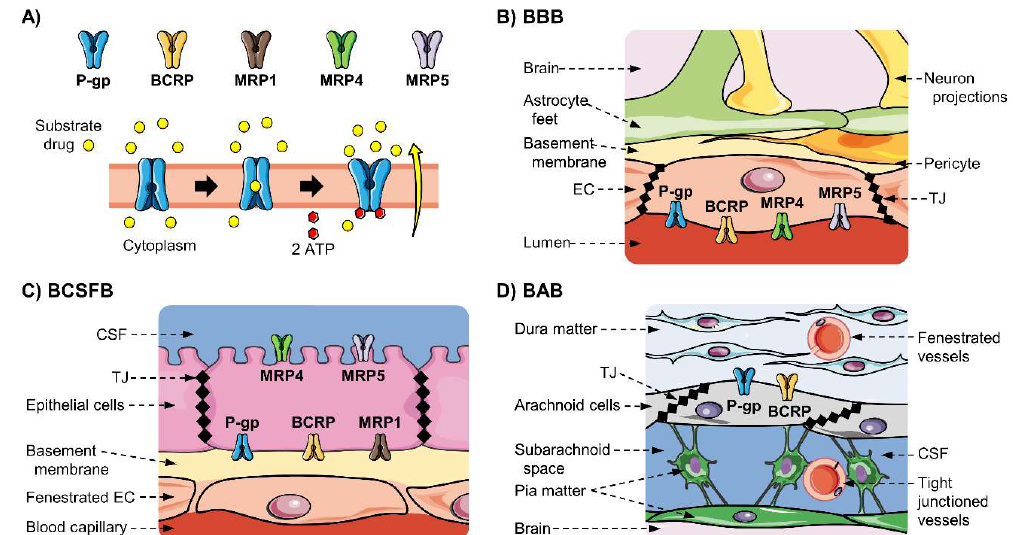
Figure 2. Efflux mechanism and localization of drug-related ATP-binding cassette (ABC) transporters at the human blood–brain interfaces: ( A ) (top) ABC transporters P-glycoprotein (P-gp/MDR1), breast-cancer resistance protein (BCRP), multidrug-resistance proteins 1, 4 and 5 (MRP1, MRP4 and MRP5) detected at the protein level at the blood–brain interfaces in non-pathological human brain; and ( A ) (bottom) simplified schema of their active transport mechanism, where substrates are effluxed against the concentration gradient in an ATP-dependent manner. Schemas showing the polarized localization of ABC transporters at the ( B ) blood–brain barrier (BBB), ( C ) the blood–cerebrospinal fluid barrier (BCSFB) at the choroid plexus and ( D ) the arachnoid barrier (BAB) at the meninges. EC, endothelial cells; TJ, tight junctions; CSF, cerebrospinal fluid. Created using images from “smart Servier Medical